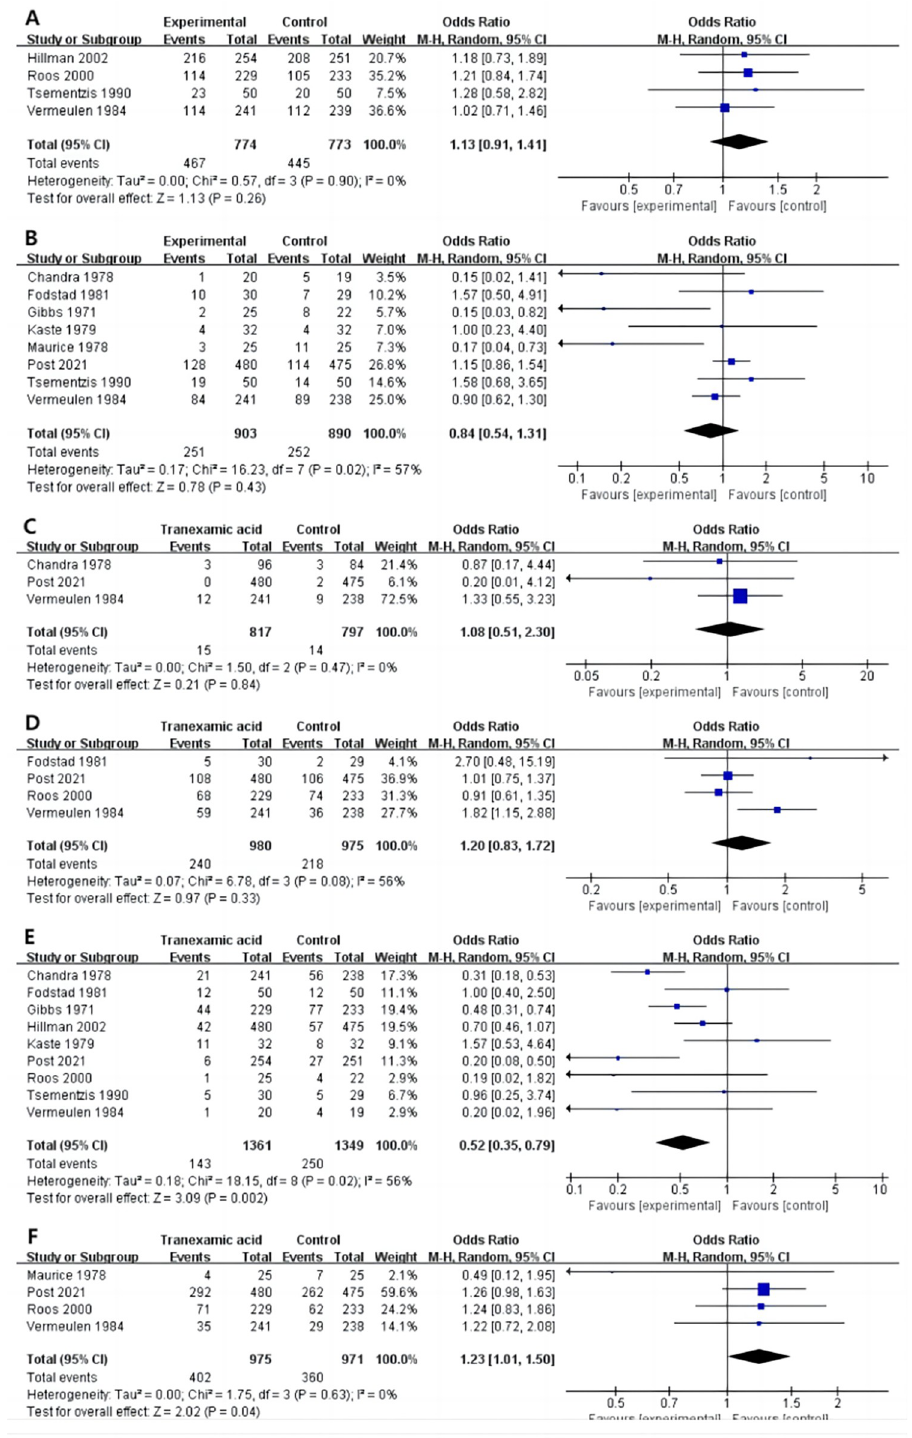
Fig 2. Forest plot of the effect of tranexamic acid on GOS 3–5 (A), Mortality (B), DVT (C), IS or TIA (D), and Rebleeding (E) in patients with SAH.